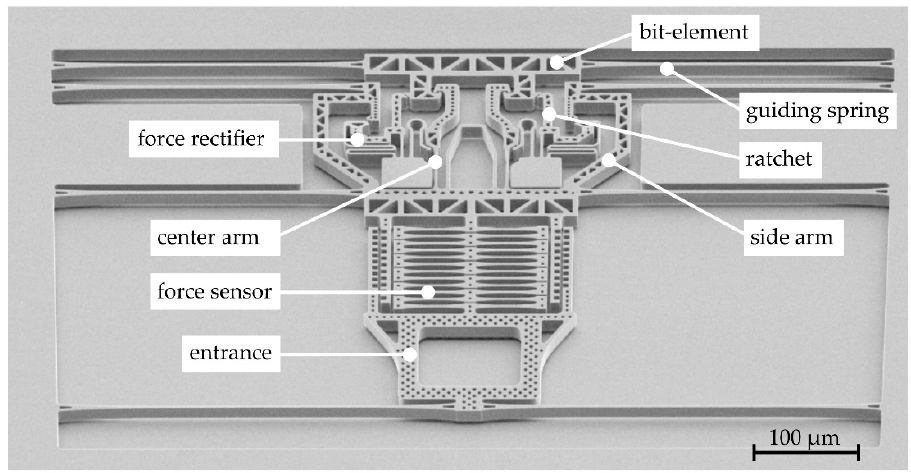
Figure 1. SEM image of a 1-bit mechanical binary counter which is set in state high (1).